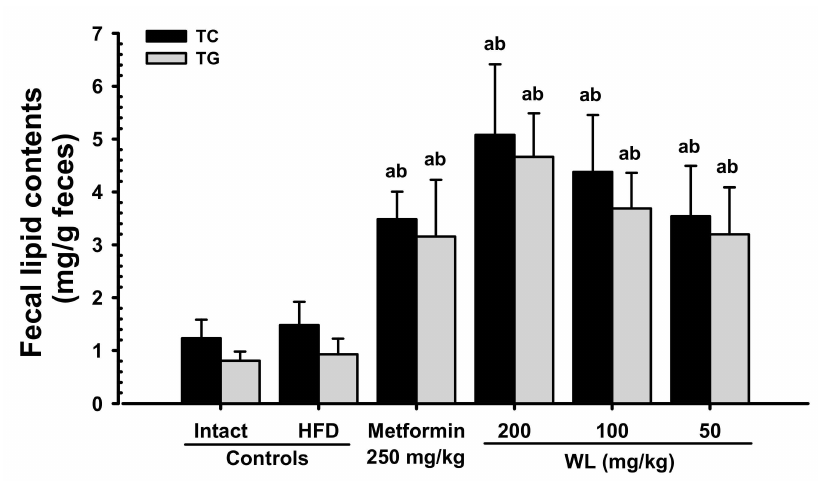
Figure 8. Fecal total cholesterol and TG content in NFD or HFD supplied mice. Values are shown as mean ± SD of eight mice. NFD = Normal pellet diet; HFD = 45% Kcal high-fat diet; WL = Wasabi Leaf / Folium, Wasabia japonica (Miq.) Matsum extracts; TG = Triglyceride. a p < 0.01—vs. intact control; b p < 0.01—vs. HFD control.